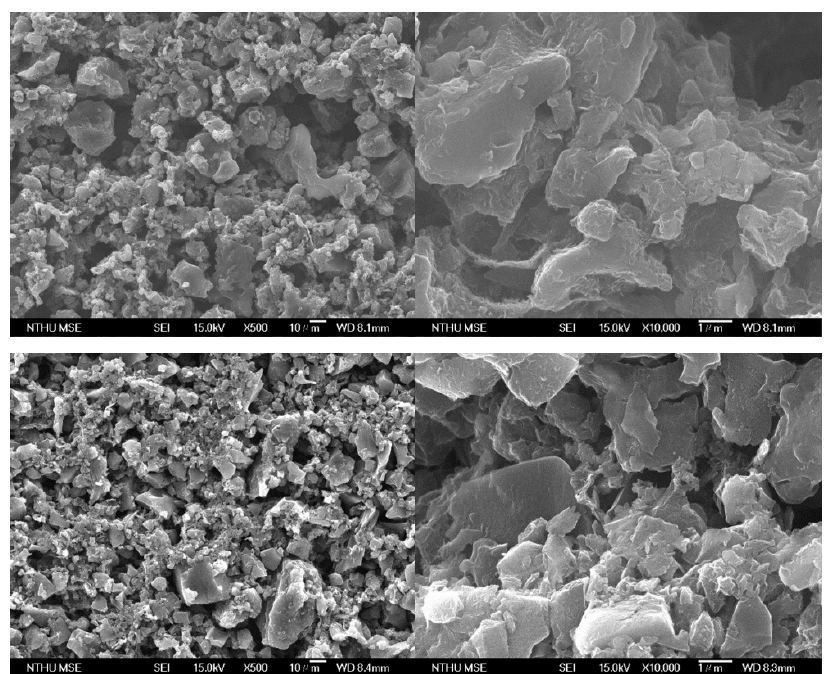
Figure 1. Scanning electron microscopy (SEM) of the electrodes: top left is AC-PU (X 500); top right is AC-PU (X 10,000); bottom left is MAIS TiO 2 /AC-PU (X 500), and bottom right is MAIS TiO 2 /AC- PU (X 10,000). (For each image, scale bars on the left are 10 microns and on the right are 1 micron).